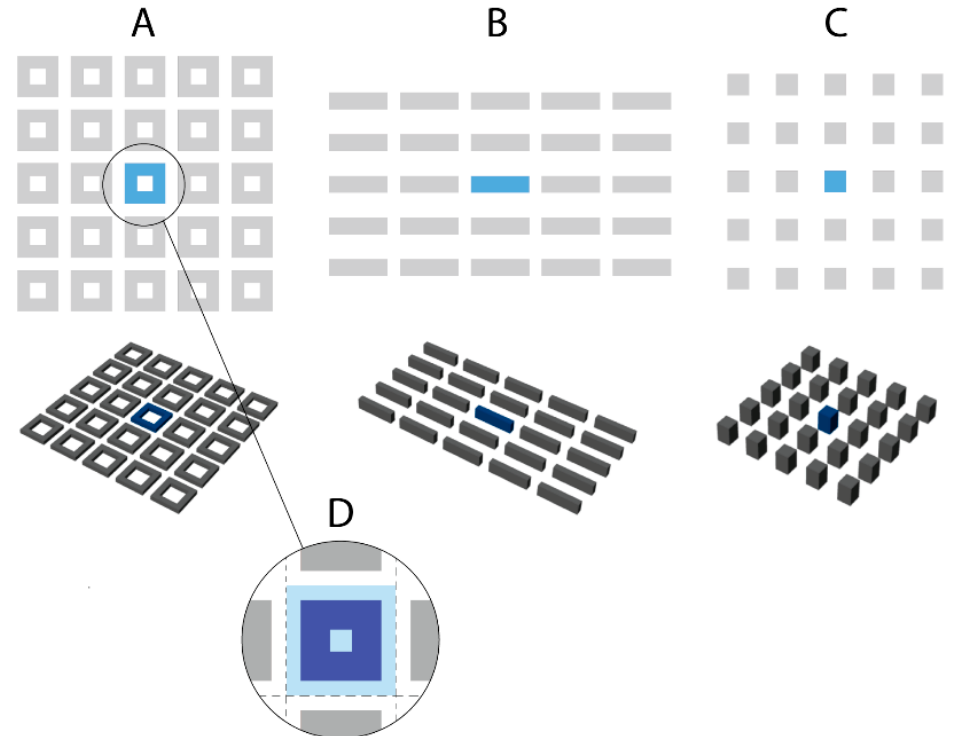
Figure 2. Exemplary iterations of the three studied neighbourhood typologies in top and perspective views: ( A )—courtyard grid, ( B )—slab grid, ( C )—tower grid, and ( D )—example of an analysed representative unit, comprising of one building and its plot (top view).